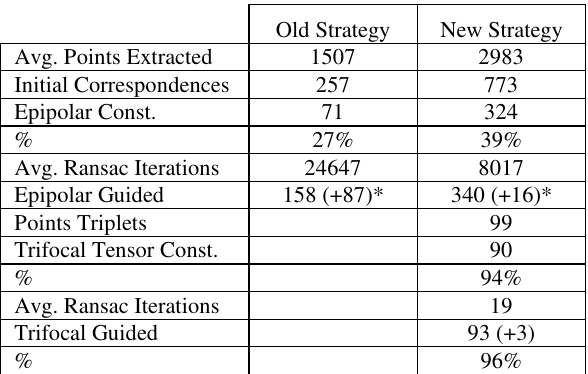
Table 7. Comparison summary of the Canopic Jar sequence.